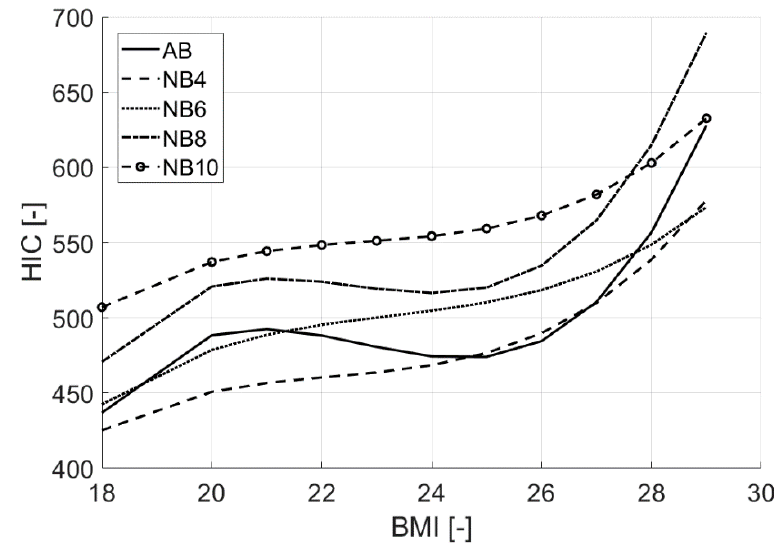
Figure 7. BMI vs HIC plots for 50 km/h pulse. Figure 7. BMI vs. HIC plots for 50 km/h pulse.